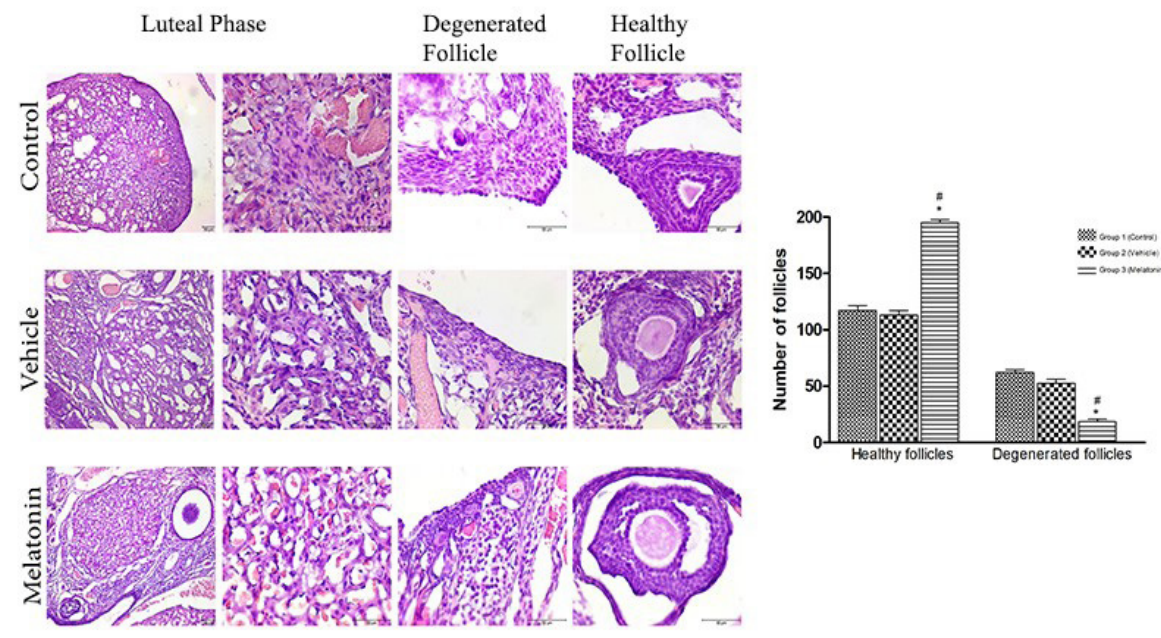
Figure 2 - Histomorphometric